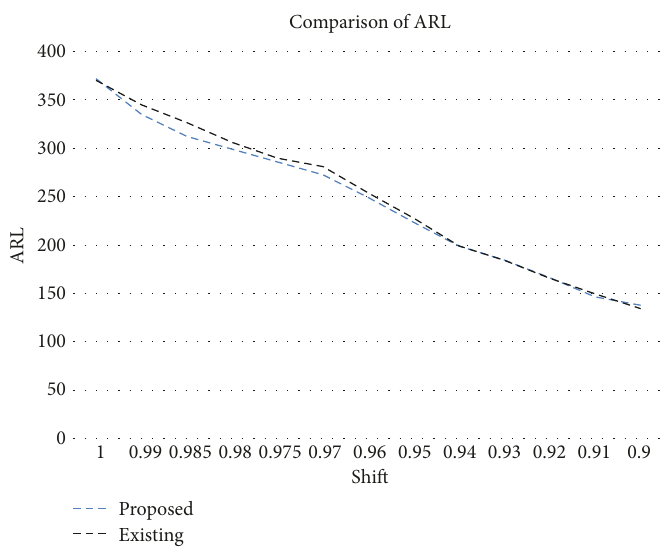
Figure 2: The ARL curve between the proposed chart and the chart in